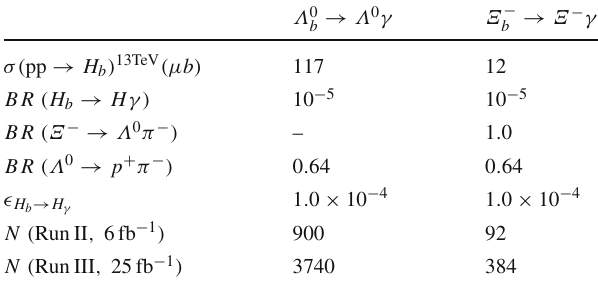
Fig. 4 a Sensitivity to the photon polarization parameter as function of its value for the Λ 0 and Ξ − decay channels. Dots with errors corre- b b spond to the fit results. A second order polynomial is superimposed for better visualization. b Statistical sensitivity of the photon polarization as function of the reconstructed number of events for the Λ 0 and Ξ − √ b b x cases. In this case was fitted to a function 1 /